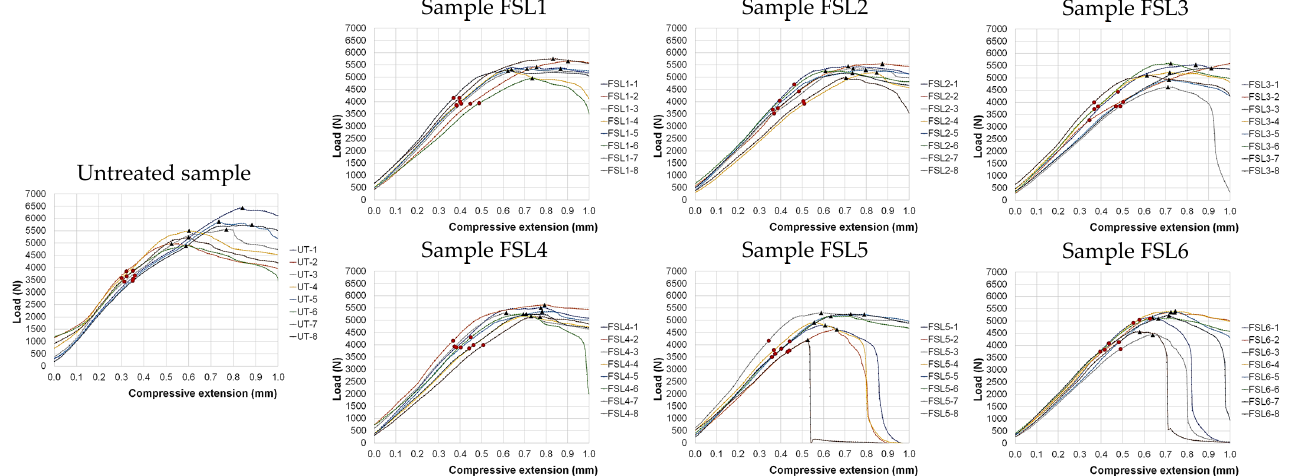
Figure 9. Force–compressive extension diagram per sample.